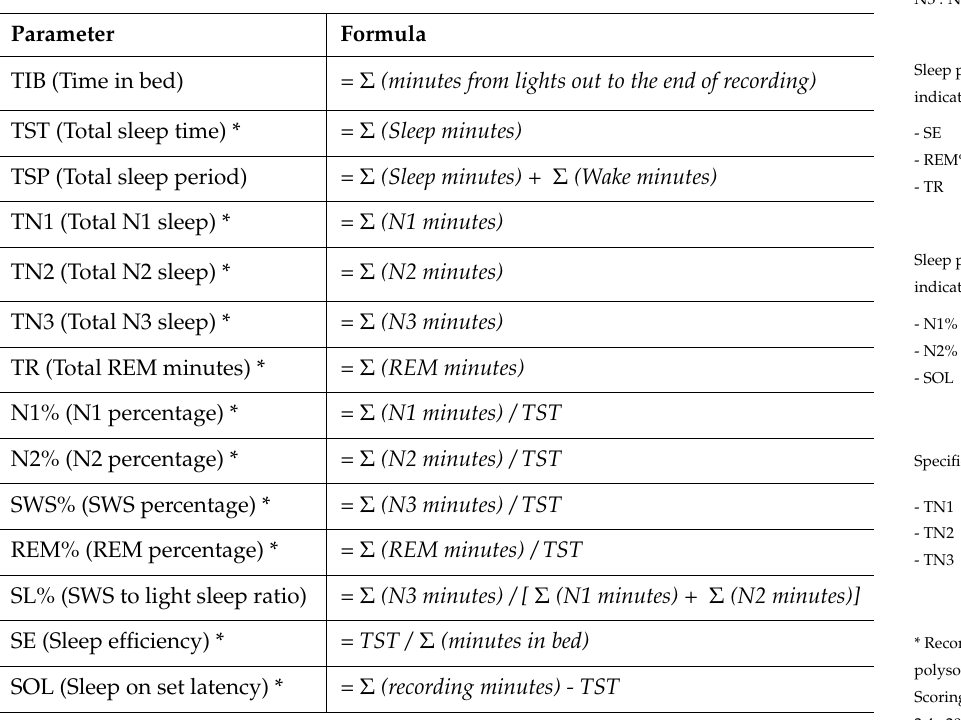
Table 1. Sleep parameter index and its simplified